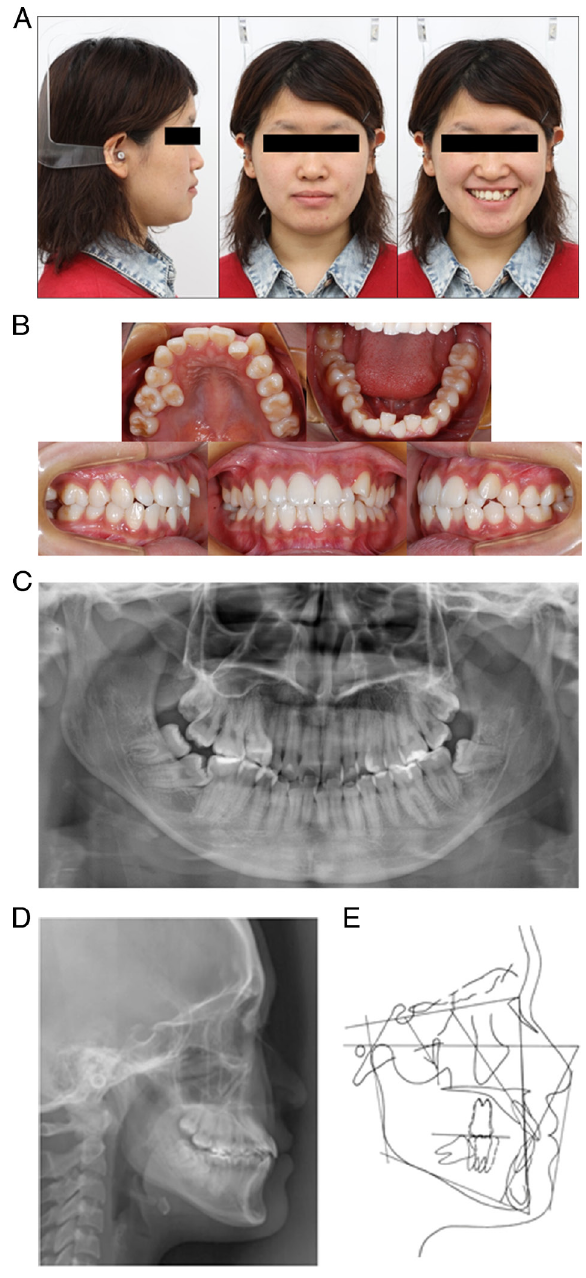
Figure 1. Pretreatment photographs and radiographs: (A) facial photo- graphs, (B) intraoral photographs, (C) panoramic radiograph, (D) lateral cephalometric radiograph and (E) lateral cephalometric tracing.